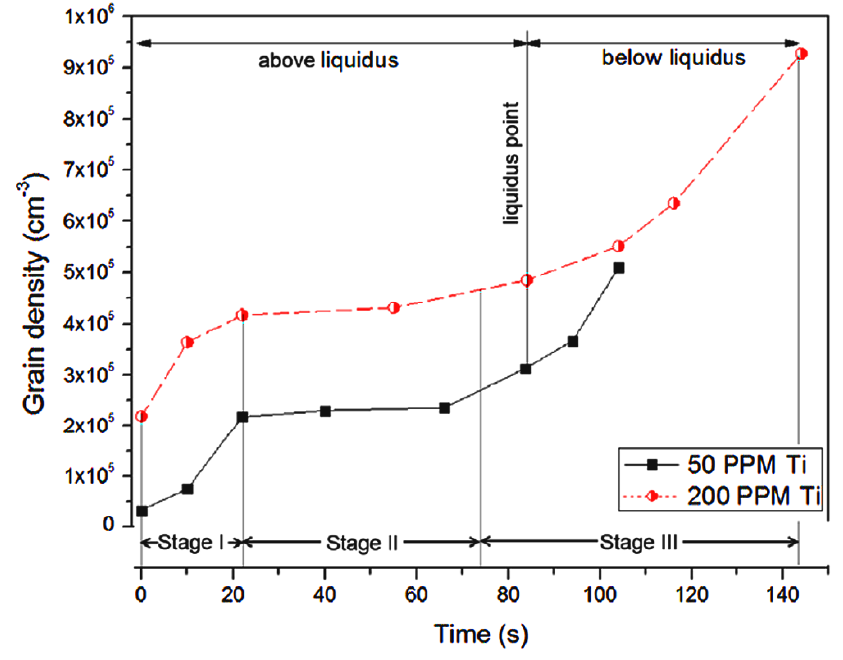
Figure 8. Increase in the grain density with respect to UST time when UST is extended below liquidus temperature of pure Al containing 50 and 200 ppm of Ti